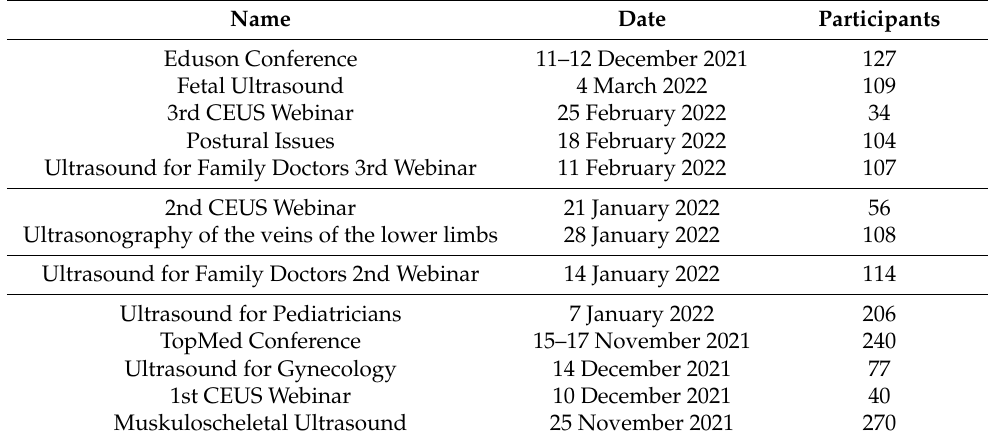
Table 1. Events tracked during the